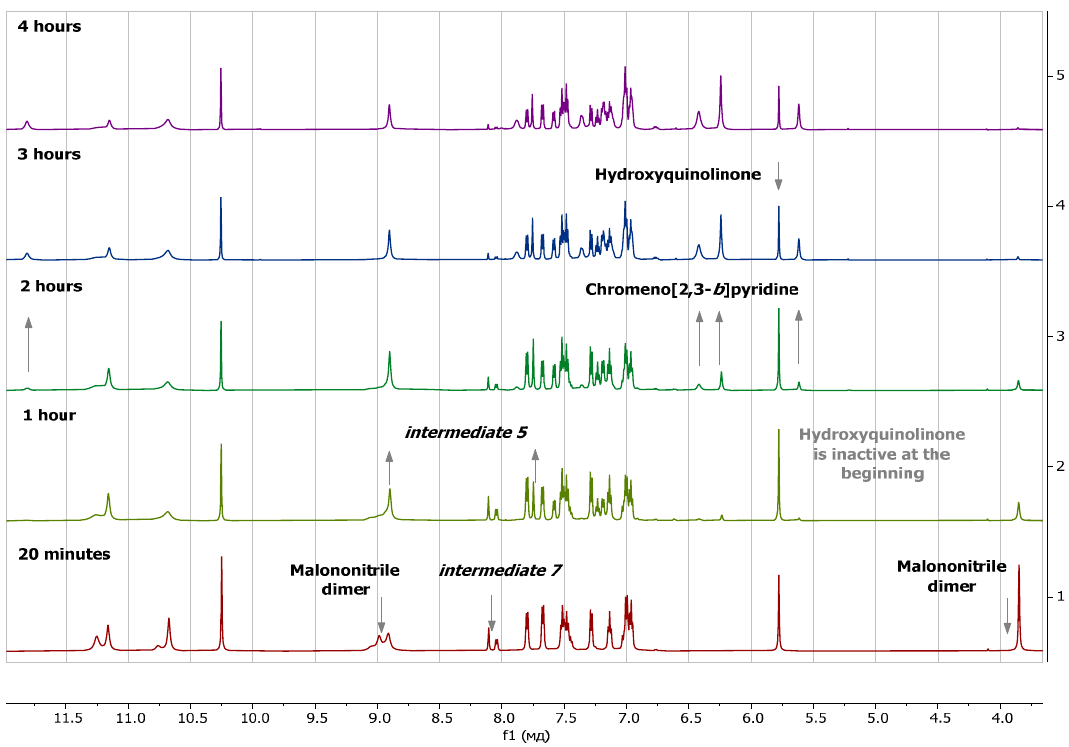
Figure 3. Real-time monitoring of chemical reaction by 1 H NMR spectroscopy in DMSO- d 6 at 313 K. The NMR spectra of all the synthesized compounds, as well as the NMR spectra of the real-time monitoring are presented in Supplementary Materials (Figures S1-S42).